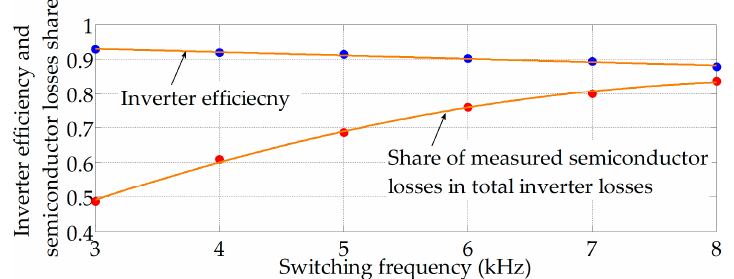
Figure 10. Inverter e ffi ciency and share of measured semiconductor losses in total inverter losses with respect to switching frequency. respect to switching